Question: Express in one sentence what the figure is showing.
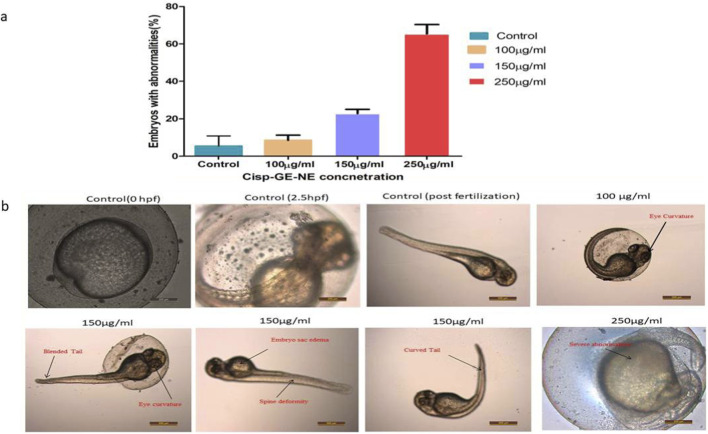
Answer: Teratogenic effects of Cisp-GE-NE in zebrafish embryos (a) A bar graph showing a clear dose-dependent increase in embryonic abnormalities after exposure to Cisp-GE-NE. At 250 μg/mL, 65% of embryos showed deformities, compared to 5% in controls. Lower concentrations (100 and 150 μg/mL) caused milder effects. (b) Representative images of zebrafish embryos across treatment groups. Control embryos showed normal development, while treated groups exhibited abnormalities such as eye curvature, spinal deformity, tail malformation, and yolk sac edema. The severity of these defects increased with concentration, with the most prominent changes at 250 μg/mL.